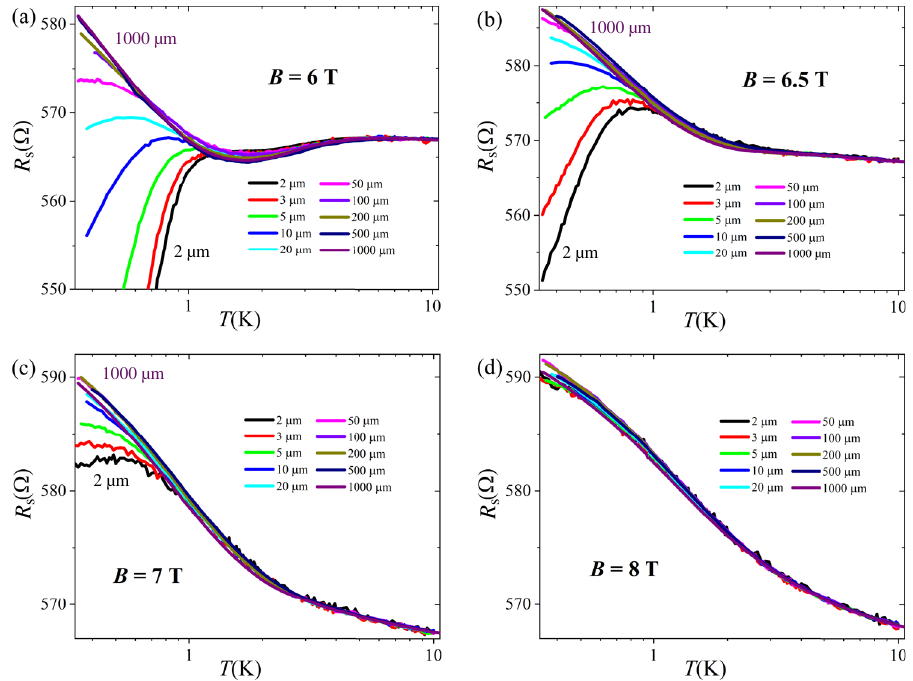
Fig. 3 Recovery of superconductivity in magnetic fi elds between the Bose insulator quantum critical fi eld B 1 c ¼ 5 : 42T and the Fermi insulator quantum critical fi eld B F c ¼ 7 : 25T upon decreasing the bridge width. a – d Sheet-resistance R s T ð Þ curves of all the bridges taken in magnetic fi elds B = 6, 6.5, 7, and 8 T,